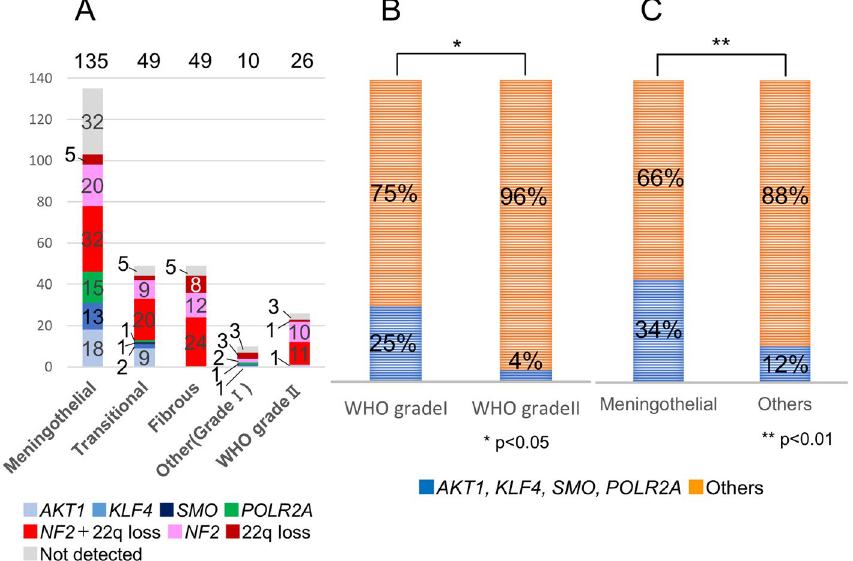
Figure 4. Distribution of genetic mutations among different pathological diagnosis. ( A ) The number of patients harboring mutations for each pathological diagnosis. ( B ) Comparison of the ratio of patients harboring AKT1 , KLF4 , SMO , or POLR2A mutations between WHO grade I and WHO grade II tumors. The ratio of patients harboring AKT1 , KLF4 , SMO , or POLR2A mutations was significantly higher for WHO grade I than for WHO grade II tumors ( p < 0.05, significant on the chi-square test with Bonferroni correction). ( C ) Comparison of the ratio of patients harboring AKT1 , KLF4 , SMO , or POLR2A mutations between meningothelial meningioma and other pathologies. The ratio of patients harboring AKT1 , KLF4 , SMO , or POLR2A mutations was higher for meningothelial meningioma than for other pathologies ( p < 0.01, significant on the chi-square test with Bonferroni